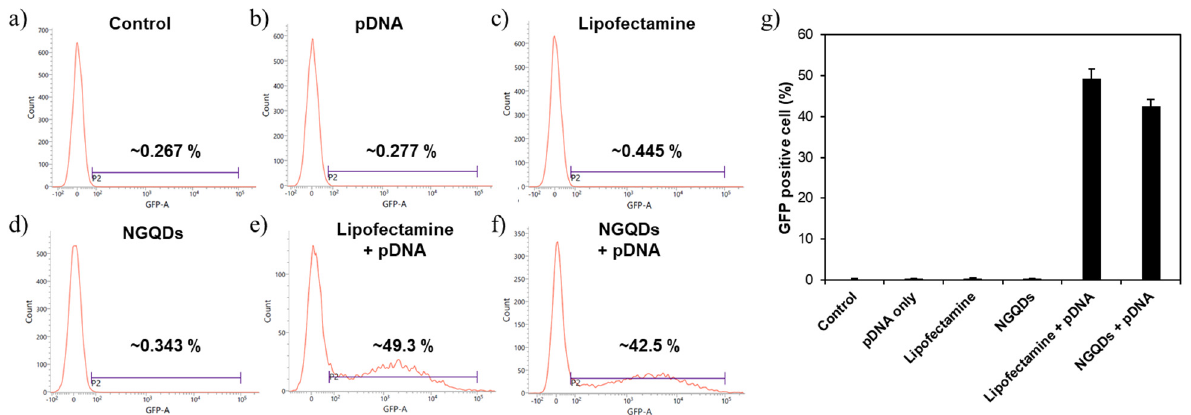
Figure 8. Flow cytometry analysis of HeLa cells after 24 h transfection with each group; ( a ) control, ( b ) pDNA only, ( c ) Lipofectamine only, ( d ) NGQDs only, ( e ) Lipofectamine + pDNA complex, ( f ) NGQDs + pDNA complex groups. ( g ) pDNA transfection efficiency of each group.